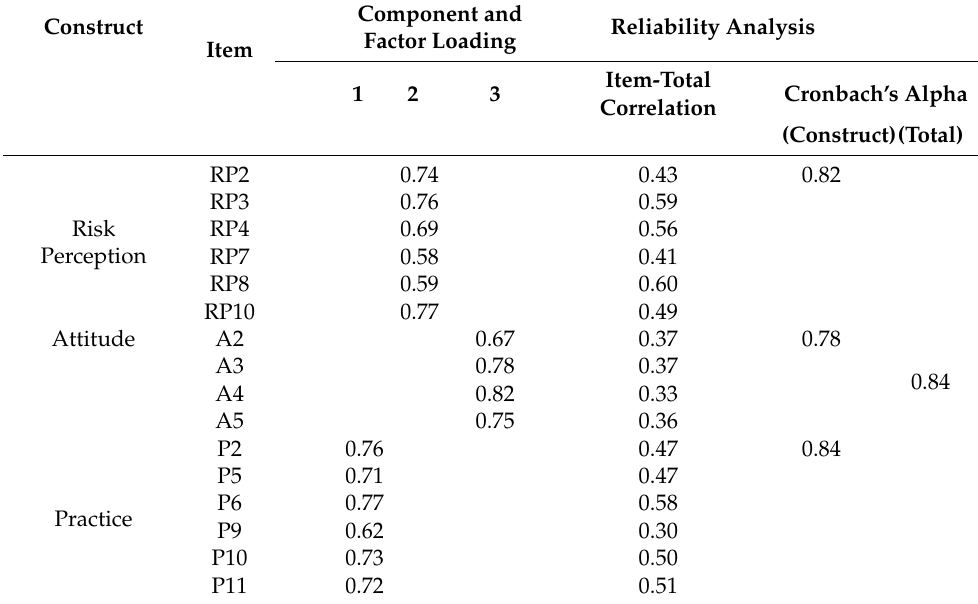
Table 4. Pilot study for risk perception, attitude, and practice constructs.